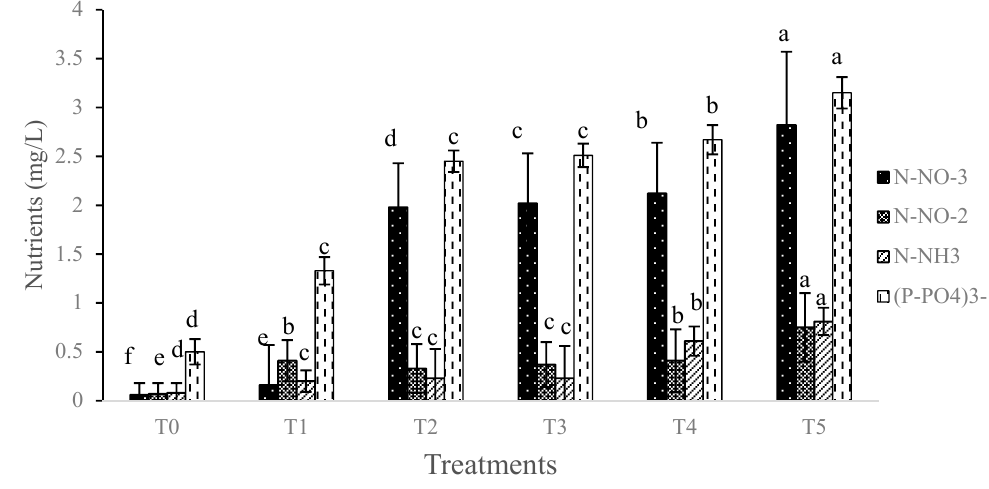
Figure 1. Mean concentrations of nutrients in the different culture media. For the same parameters, means followed by the same letters are not significantly different ( p > 0.05). T 0 (the control), T 1 , T 2 , T 3 , T 4 , and T 5 correspond, respectively, to 0, 300, 600, 900, 1200, 1500 g of dry rabbit manure (RM).